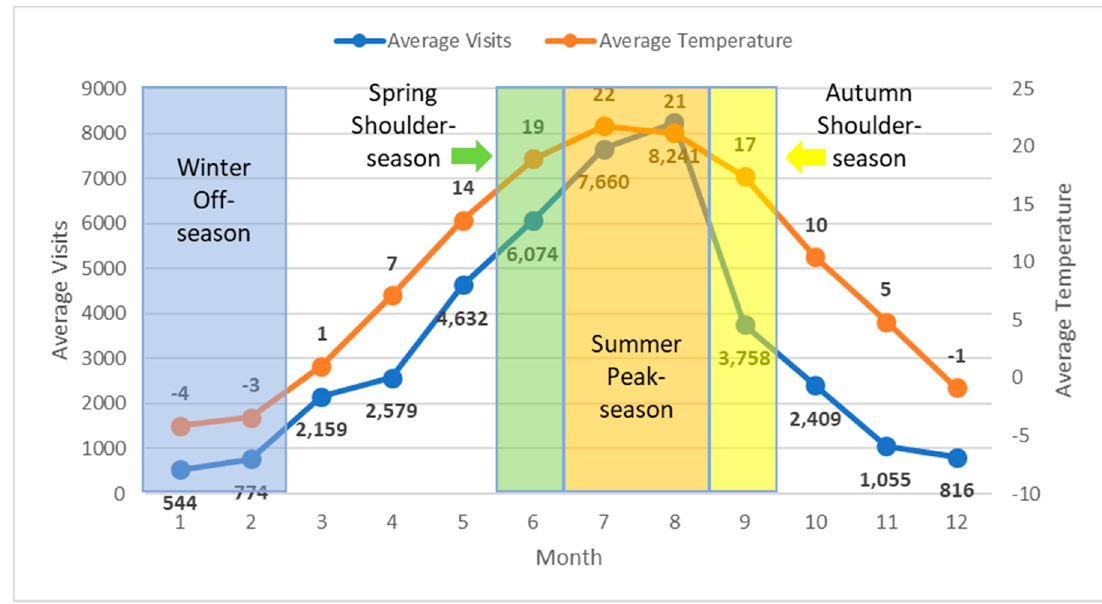
Figure 2. The seasonality of average zoo attendance and average temperature in Toronto (Canada) from 1999 to 2018 (also showing the constitution of the four seasons being analyzed).